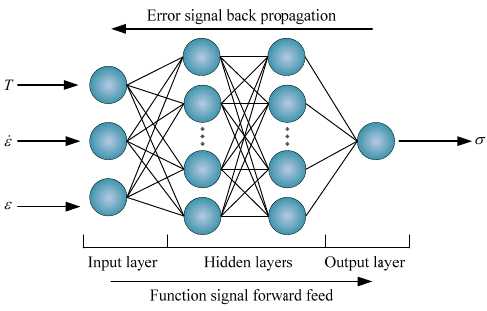
Figure 2. The schematic of the back ‐ propagational artificial neural network architecture.